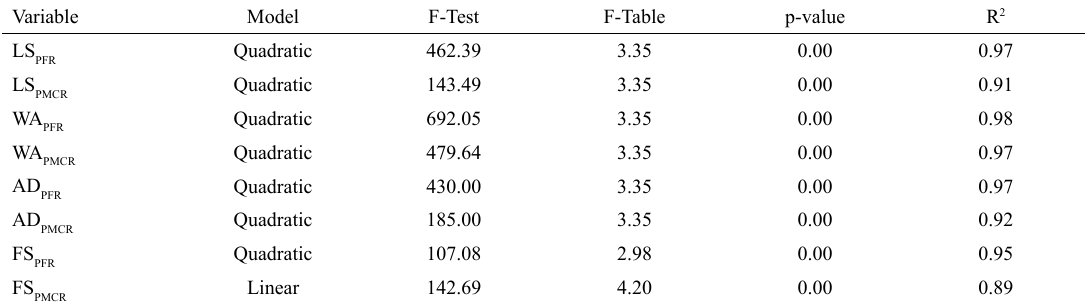
Table 5. Relevant statistics for the analysis of variance of the mathematical models that describe the variables LS, WA, AD and FS, for PFR and PMCR compositions. Variable Model F-Test